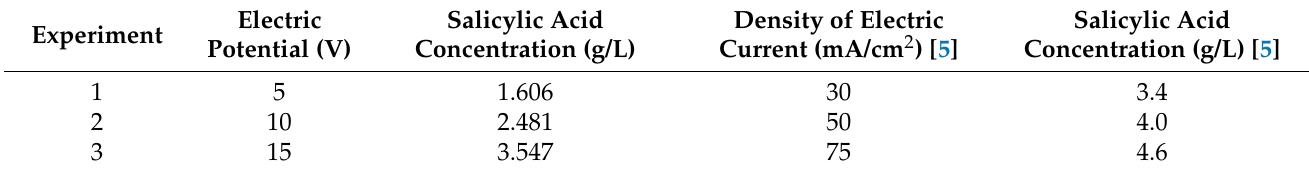
Table 7. Comparative data for salicylic acid concentration and current density.